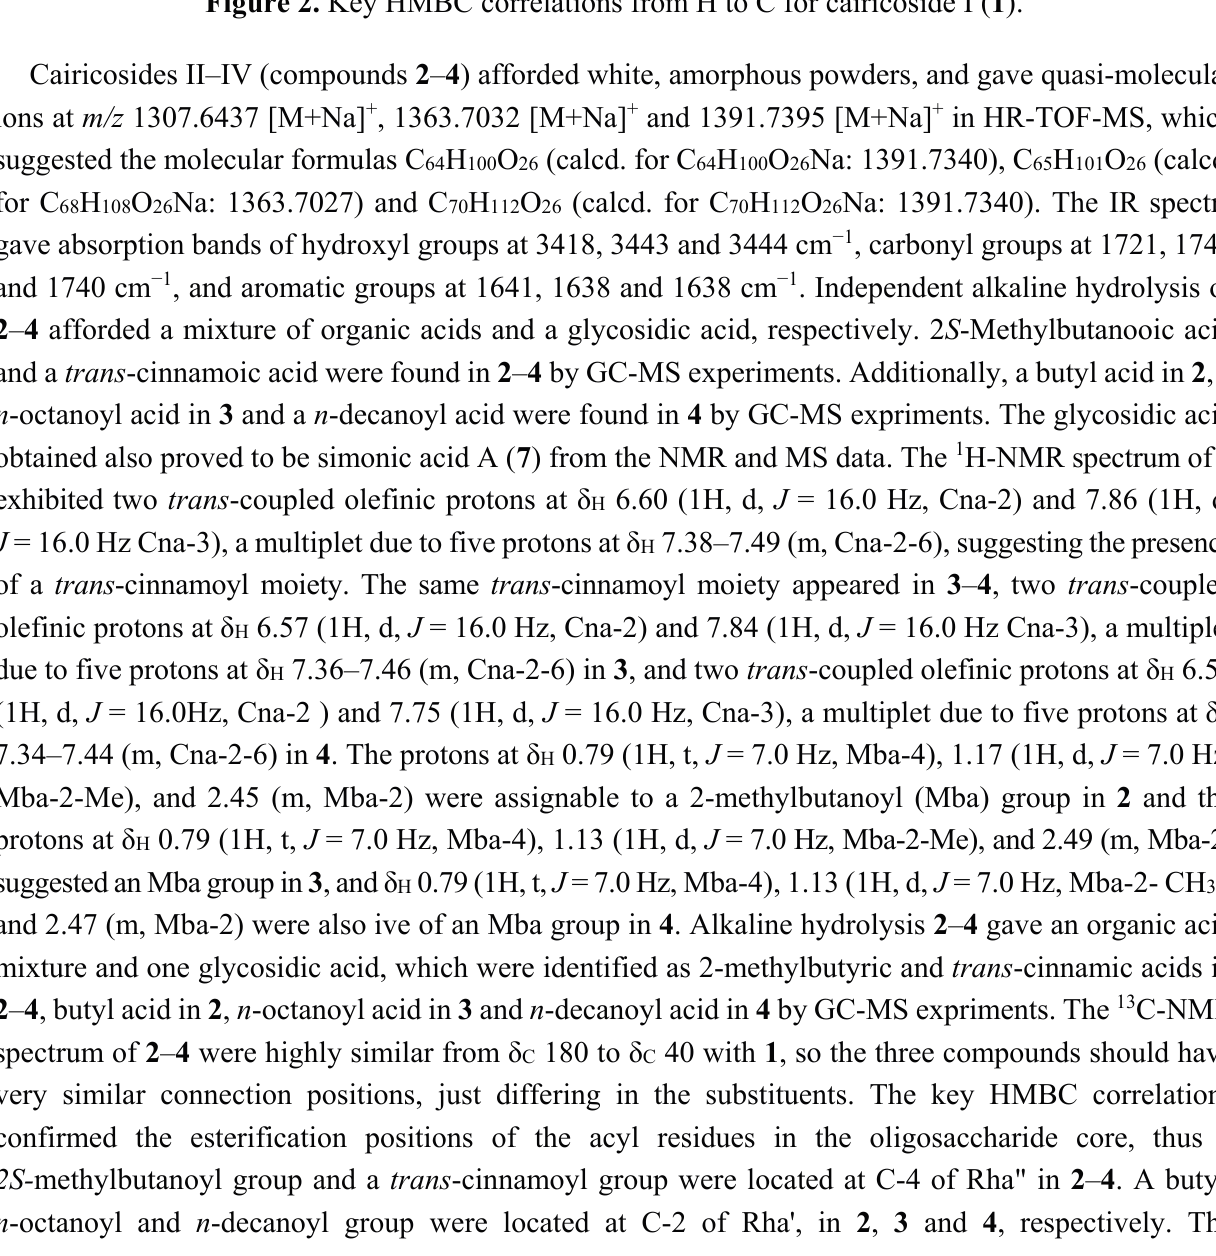
Figure 2. Key HMBC correlations from H to C for cairicoside I ( 1